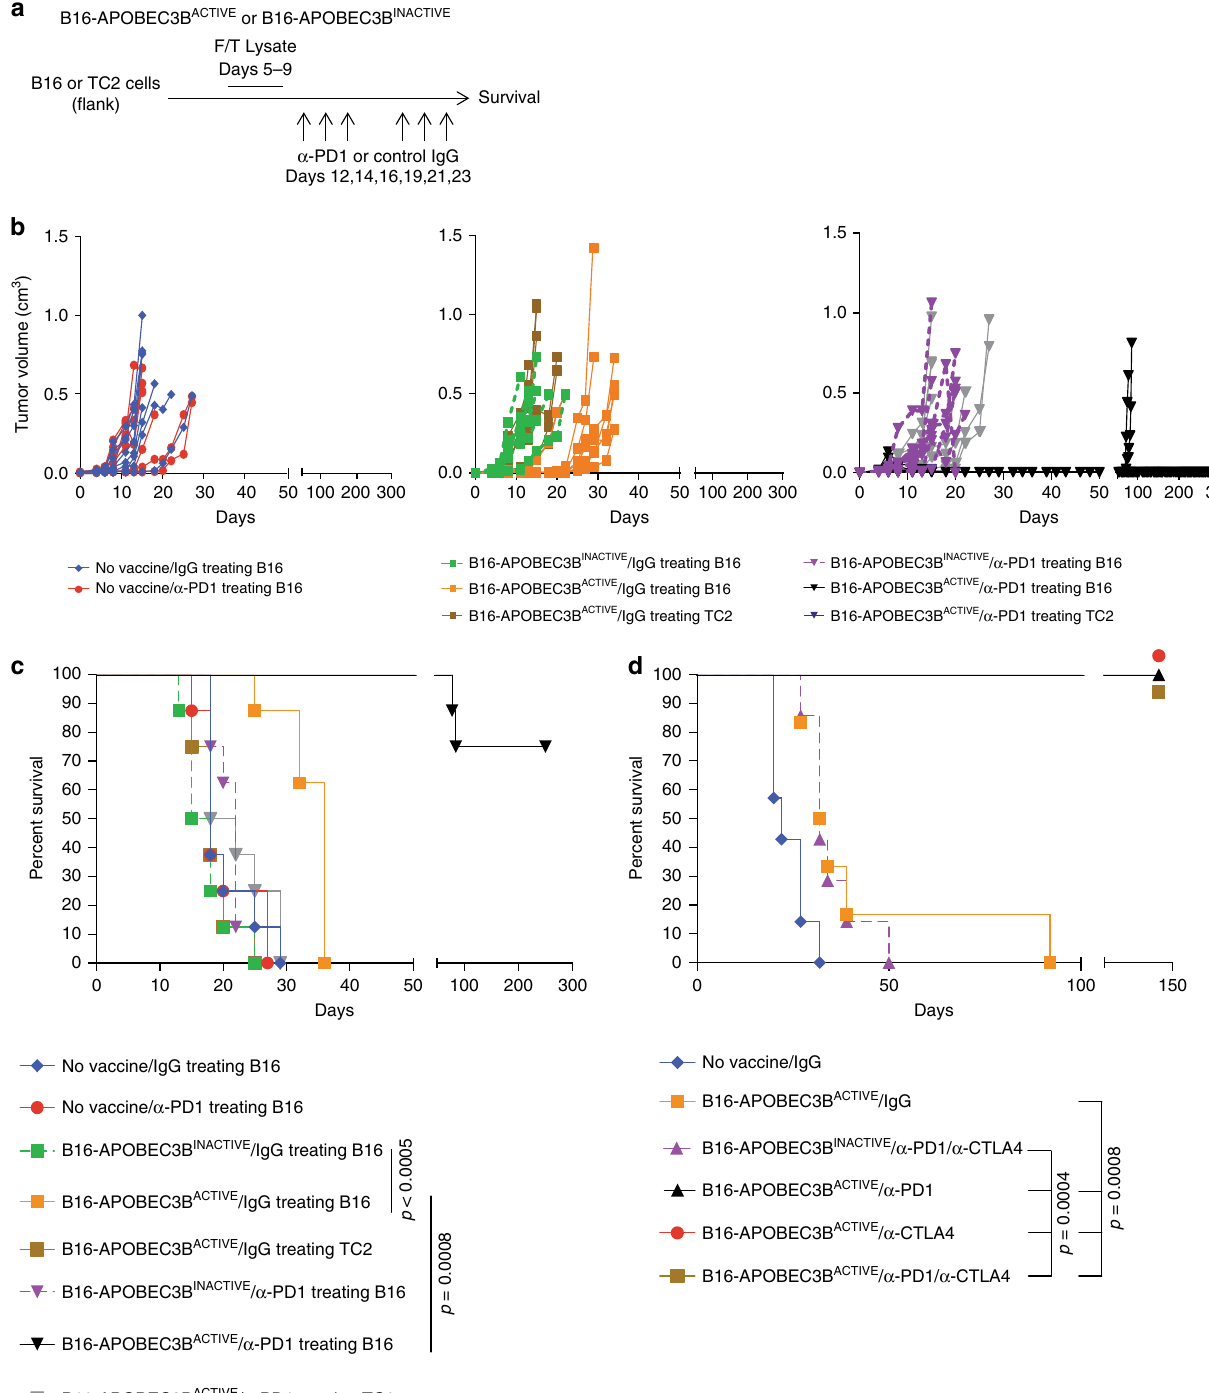
Fig. 2 APOBEC3B enhances B16 cell lysate vaccine and synergizes with immune checkpoint blockade therapy. a On day 0, 2 × 10 5 B16 murine melanoma or TC2 murine prostate carcinoma were implanted subcutaneously into the right fl ank of C57Bl/6 mice. One 5-day course of APOBEC3B ACTIVE or APOBEC3B INACTIVE -modi fi ed B16 cell vaccines (freeze/thaw lysate of 10 6 cells i.p.) was administered from days 5 to 9. This was followed by anti-PD1 antibody or IgG control (12.5 mg/kg i.p.) on days 12, 14, 16, 19, 21, and 23. b Mice ( n = 8/group) were treated according to the regimen in ( a ) and tumor volumes were measured three times per week. c Kaplan – Meier survival curves representing experiment described by ( a ) and ( b ). Representative of 5 experiments. d Treatment of subcutaneous B16 murine melanomas as in ( a ), except with the addition of anti-CTLA4 antibody (5 mg/kg i.p.) as a monotherapy or in combination with anti-PD1 ( n = 7 mice/group). The black triangle, red circle, and brown square symbols represent three separate groups of 7 mice treated with B16-APOBEC3B ACTIVE vaccine with anti-PD1, anti-CTLA4, or anti-PD1/anti-CTLA4 antibody therapy that all had 100% survival at 150 days. This experiment was repeated once. Groups were compared using a Log-Rank test with Holm – Bonferroni correction for multiple